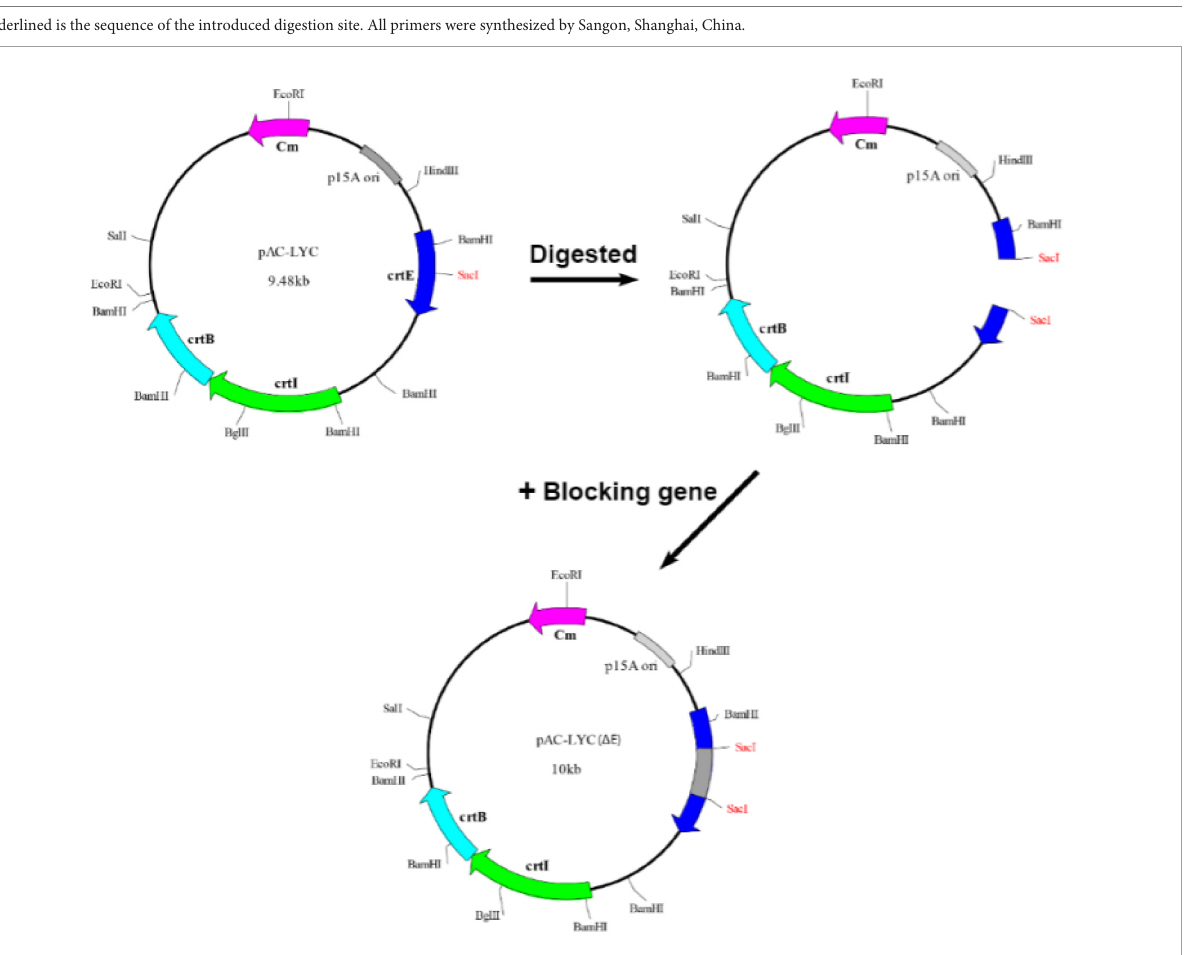
FIGURE1 Construction of pAC-LYC ( (cid:49) E ). A sequence not coding a functional protein was inserted into the pAC-LYC plasmid at the Sac I position of the crtE gene. The crtE gene was rendered incapable of expressing functional proteins, but did not affect the expression of the crtB or crtI